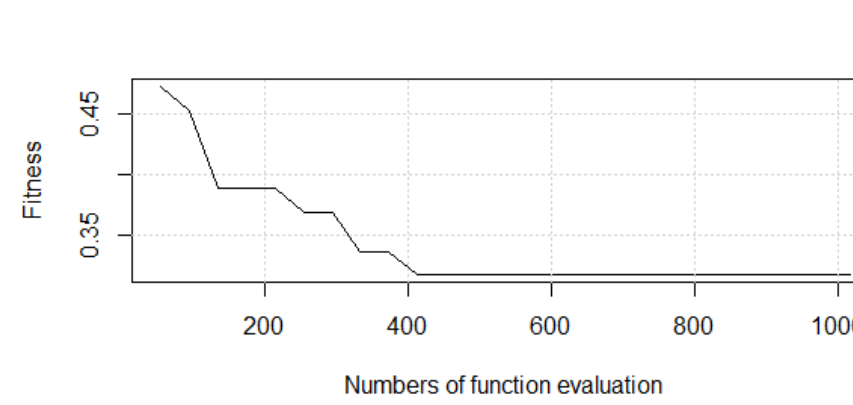
Figure 3: Convergence plots for the Multiple Disc Clutch Brake using Bees Algorithm